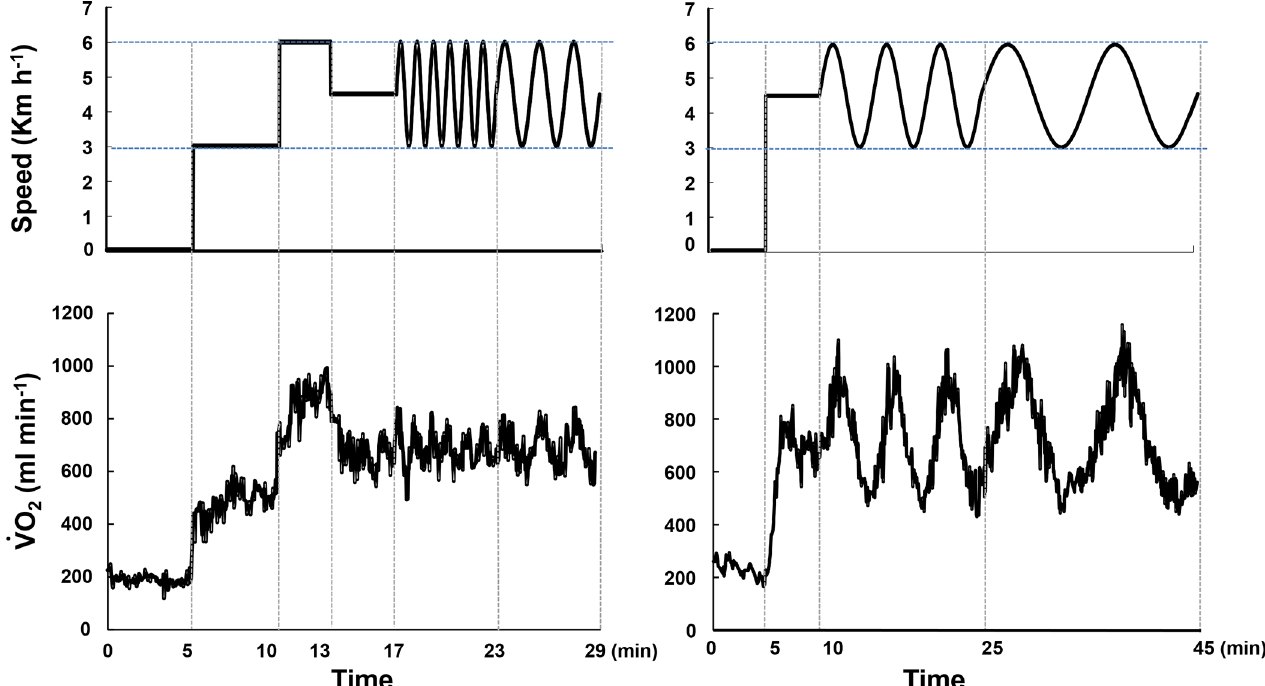
Fig 1. Walking protocol at sinusoidally changing speed following three different constant walking speeds. Treadmill walking was started after 5 min of rest, and consisted of 5 min at 3 km (cid:1) h −1 , 3 min at 6 km (cid:1) h −1 , and 4 min at 4.5 km (cid:1) h −1 for a total of 12 min of walking. After three consecutive exercises, the sinusoidal speed change between 3 and 6 km (cid:1) h −1 was controlled by a PC in four different periods (1, 2, 5, and 10 min) (upper panel). At the same time, the measured breath-by-breath _ VO 2 values were obtained (lower